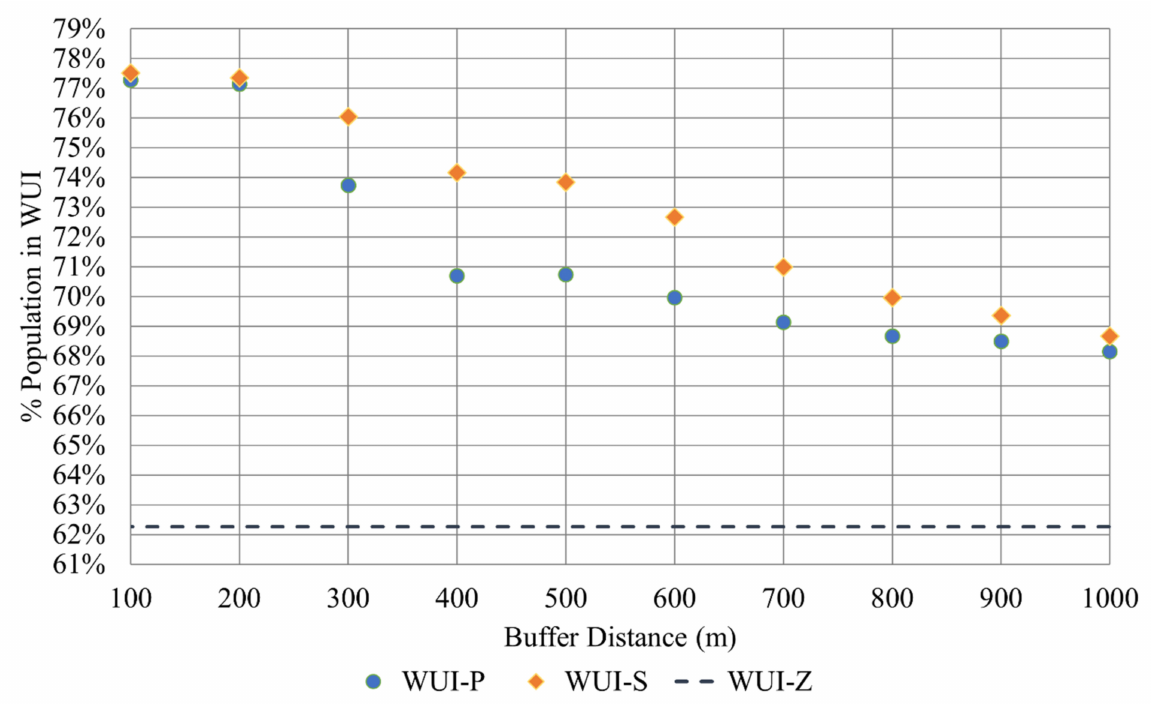
Figure 8. Percentage of population within each WUI at different buffer